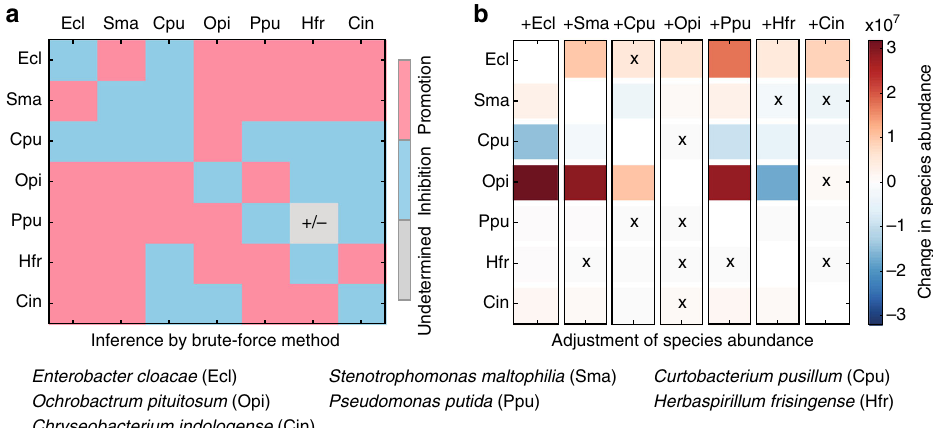
Fig. 6 Inferring interaction types in a synthetic community of maize roots with seven bacterial species. The data set consists of seven sextets and one septet. a Without considering the one septet, we analyze the seven sextets (steady-state samples involving six of the seven species). We use the brute- force method to infer the ecological interaction types, i.e., the sign-pattern of the Jacobian matrix. Blue (or red) means inhibition (or promotion) effect of species j on species i , respectively. One sign (gray) is undetermined from the seven sextets. b The changes of species abundance before and after, respectively, adding one species into a sextet. Blue (or red) corresponds to the decrease (or increase) of one species ’ abundance after introducing a new species into sextets, respectively. Each column corresponds to a sextet (a six-baterial community), the name of the newly introduced species is marked in the top of each column. ‘ × ’ indicates the false prediction. There are in total 12 false